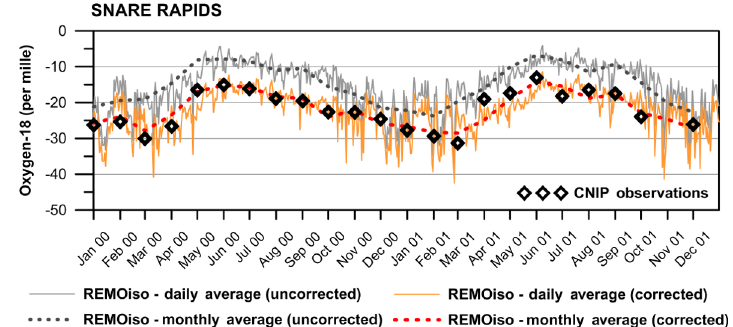
Figure 2. Comparison of raw and corrected REMOiso δ 18 O ppt output with CNIP monthly compositions at Snare Rapids, NWT.